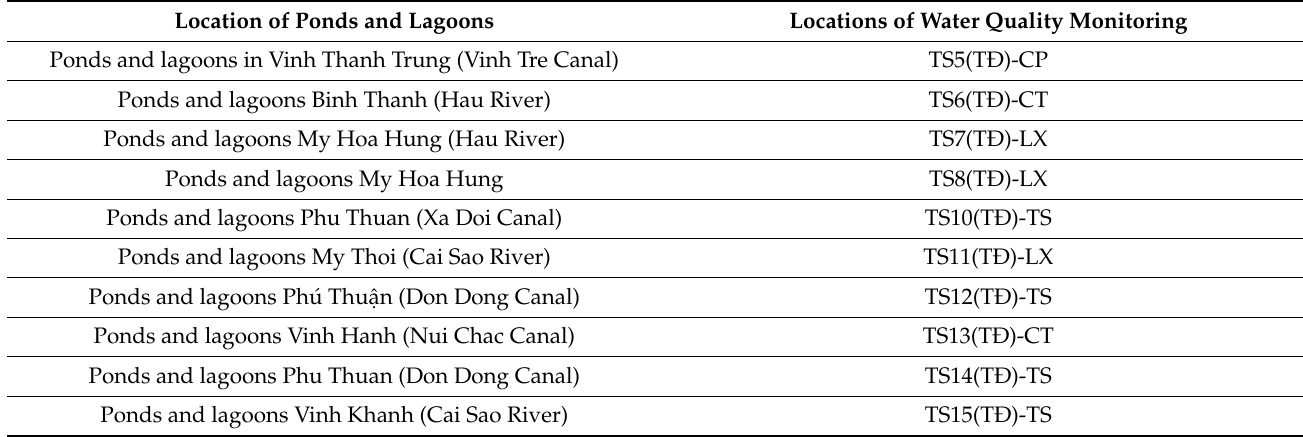
Table A1. Location of aquaculture ponds and lagoons in the study area. Location of Ponds and Lagoons Locations of Water Quality